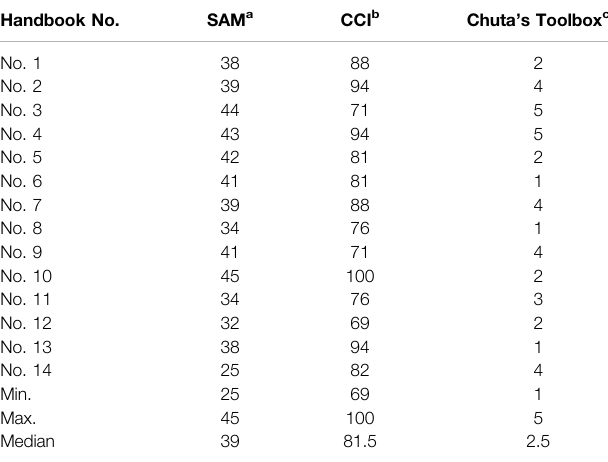
TABLE 2 | Scores by evaluation